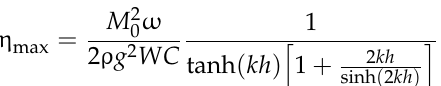
Figure 8. Excitation moment coefficient as a function of wave frequency at different floating states: ( a ) for fixed beak angle at θ b = 144°; and ( b ) for fixed depth of rotation axis at d = 5.5 m.